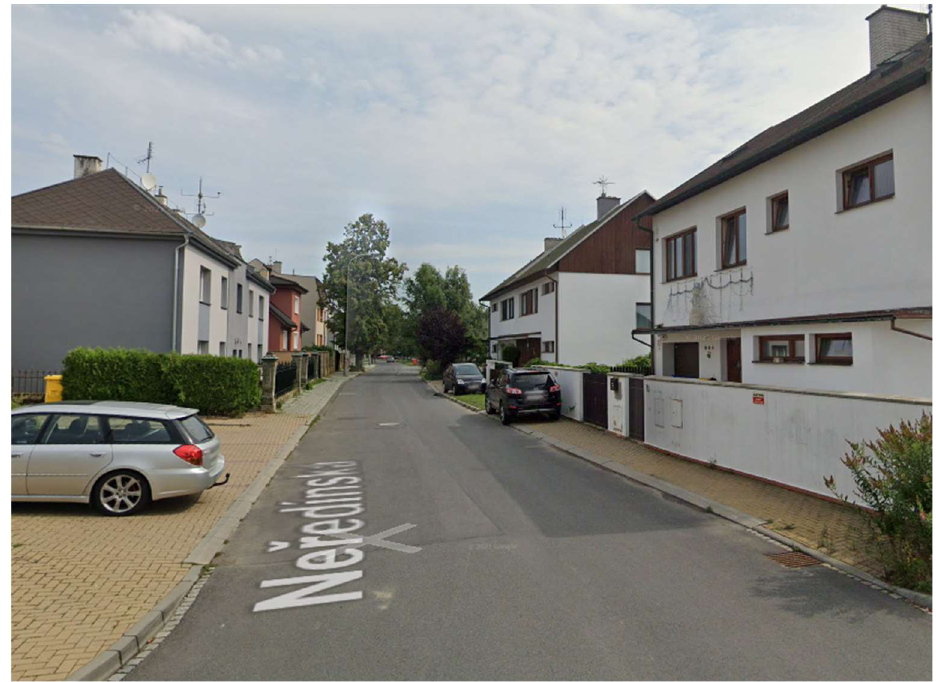
Figure 3. The residential (family houses) environment.